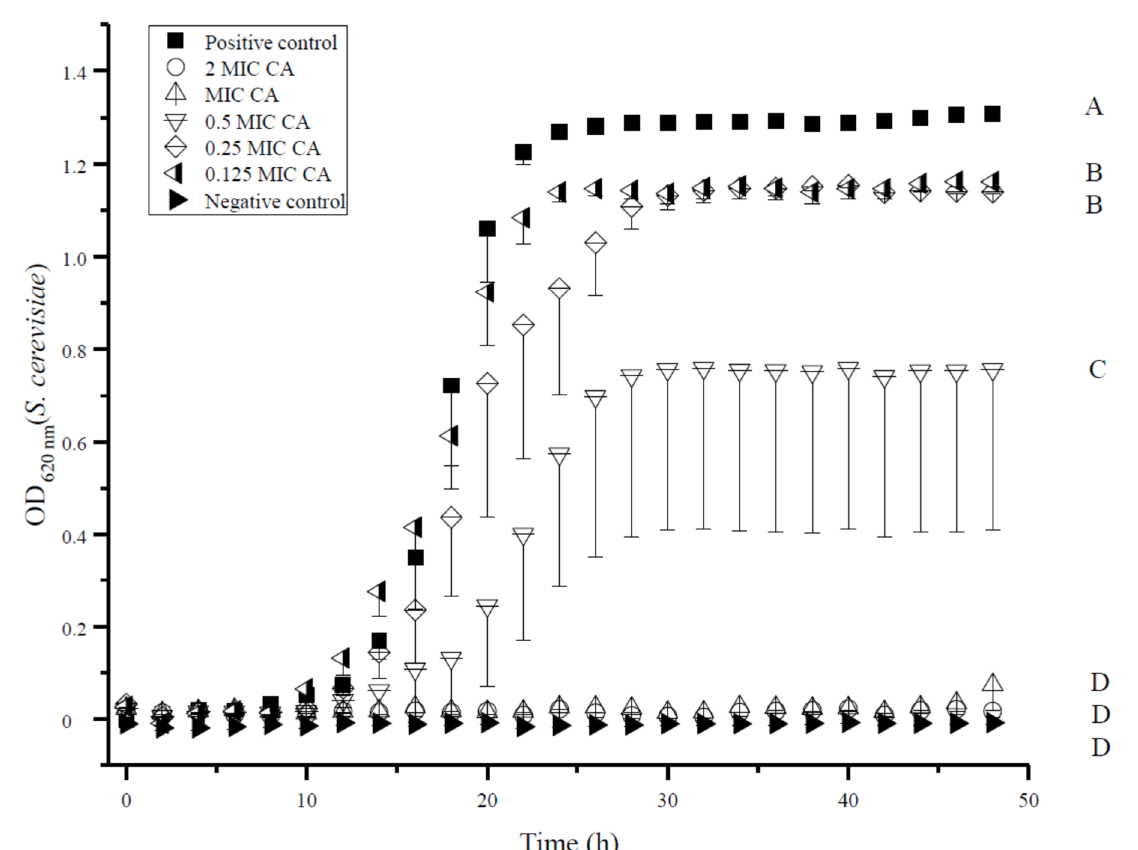
Figure 1. Effect of 0.125 minimal inhibitory concentration (MIC; 0.02 µ L mL − 1 ) of cinnamaldehyde (CA); 0.25 MIC CA (0.03 µ L mL − 1 ); 0.5 MIC CA (0.06 µ L mL − 1 ); 1 MIC CA (0.125 µ L mL − 1 ); or 2 MIC CA (0.25 µ L mL − 1 ) compared to negative control without cells and positive control without treatment with CA on the growth of S. cerevisiae over time. Error bars (only negative error bars are shown) indicate standard error of independent biological triplicate measurements ( n = 3). Different letters beside curves indicate significant differences ( p < 0.05) between different treatments according to one-way analysis of variance.